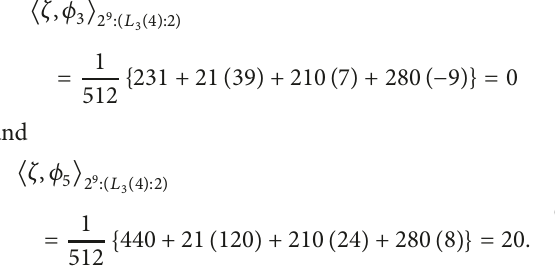
where 𝑎 1 = ⟨𝜁, 𝜙⟩ 2 9 :(𝐿 . 3 (4):2) We apply the above results to some of the irreducible are 𝜙 1 = 22𝑎 , 𝜙 2 = 22𝑏 , 𝜙 3 = 231𝑎 , 𝜙 4 = 231𝑏 , 𝜙 5 = 440𝑎 , and 𝜙 440𝑏 . Their respective degrees are 22, 22, 231, 231, 6 =